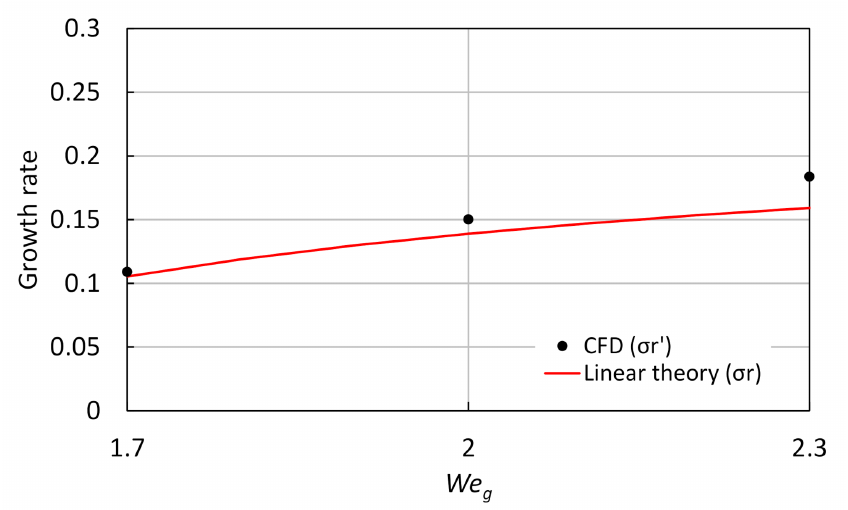
Figure 6. Effect of the growth rate on the gas Weber number ( We g ), in the case of 3000 ( X direction) × 400 ( Y direction) cells and with C α =